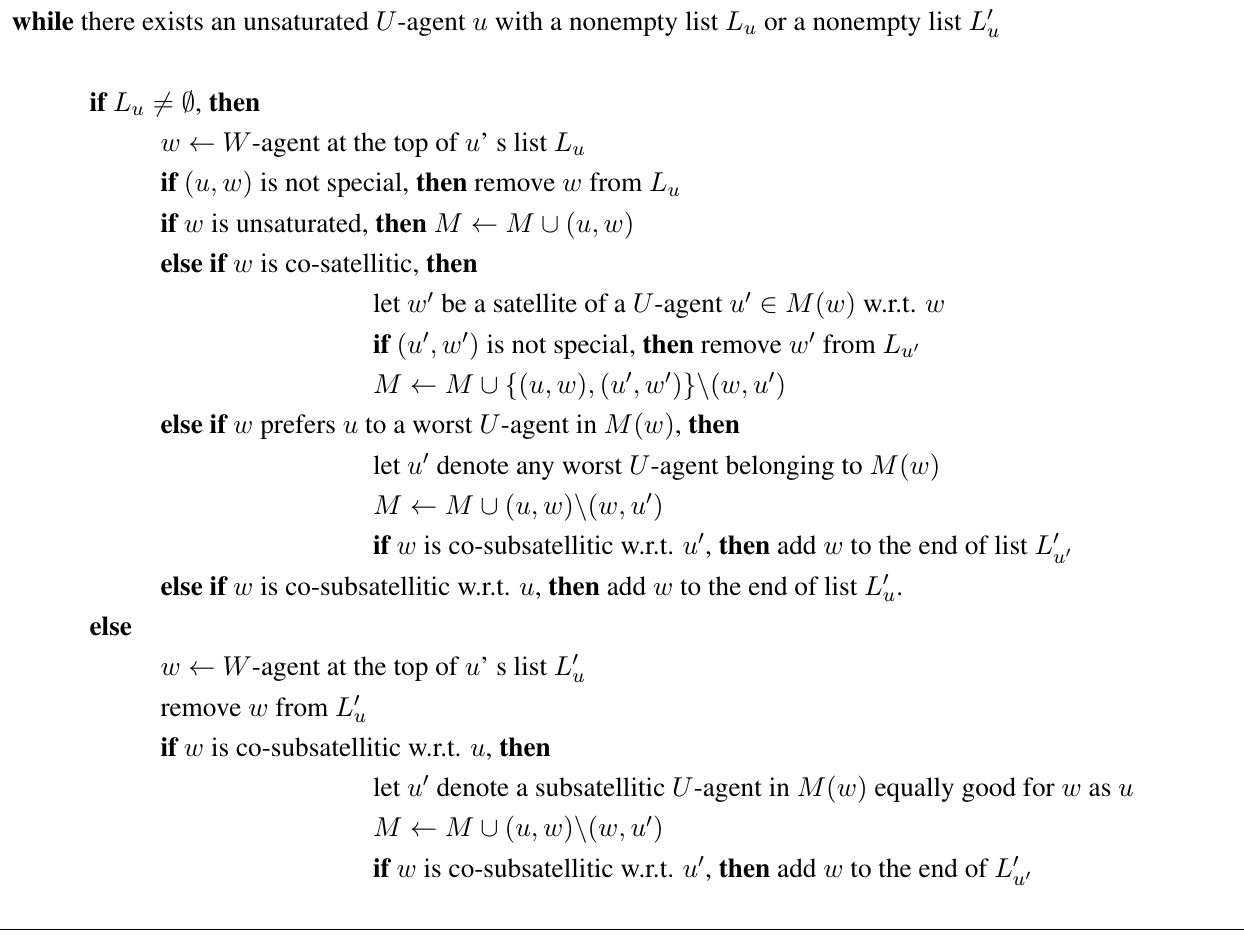
Algorithm ASBM (short for Approximate Stable b -Matching